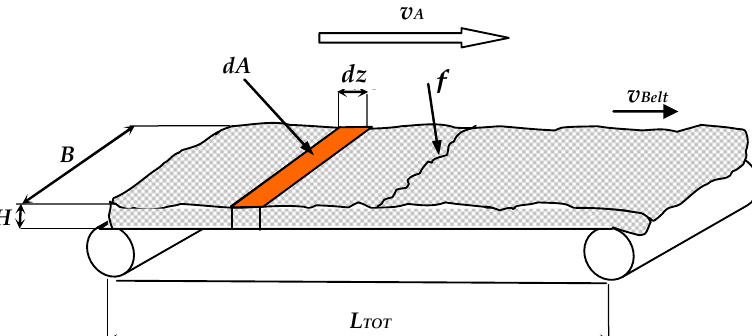
Figure 5. Conveyor-belt dryer with tangential flow in co-current: transverse dimension f ; velocity of the drying air v A ; velocity of the belt v Belt ; length of the belt L TO T ; height of the product bed H ; width of the product bed B ; elementary area of the product exposed to the air dA ; elementary length dz .